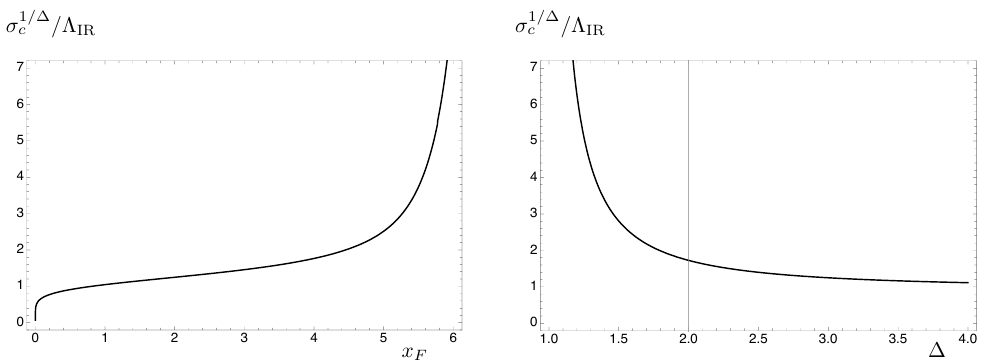
Figure 8 . Model I. The dimensionless ratio σ 1 / ∆ c / Λ IR , as a function of x F with ∆ = 3 (left panel) and as a function of ∆ with x = 2 (right panel). The vertical gray line indicates the value of F ∆ = 2 when the interpretation of σ switches from being a source ( ∆ < 2 ) or a VEV ( ∆ > 2 c